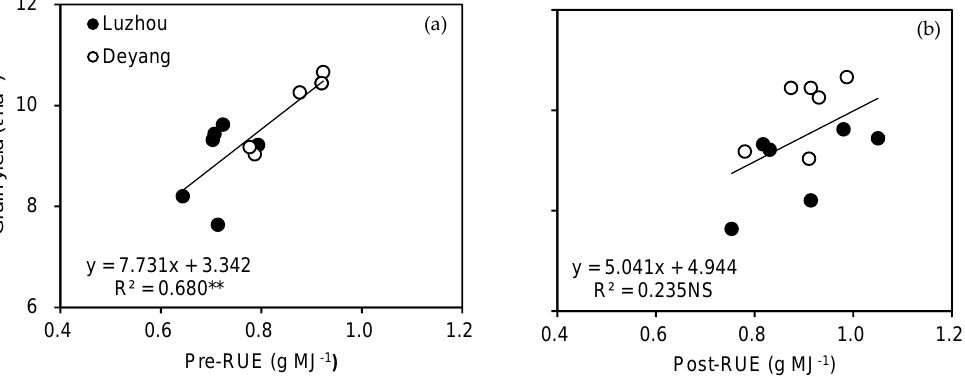
Figure 6. Relationships between grain yield and apparent radiation use efficiency (RUE) during the pre- and post-heading periods of six rice cultivars grown in two locations from 2018 to 2020. Data are averaged across three years. ( a , b ) represent the apparent radiation use efficiency during the pre- and post-heading periods of the six rice cultivars, respectively. ‘**’ denotes a significant relationship at the 0.01 probability level. ‘NS’ denotes a non-significant relationship at the 0.05 probability level. Table 6. Leaf area index (LAI) at the heading stage, crop growth rate (CGR, g m −2 d −1 ), and apparent radiation use efficiency (RUE) from transplanting (TR) to heading (HD) and HD to maturity (MA) of six rice cultivars grown under two different ecological conditions in a field experiment from 2018 to 2020.